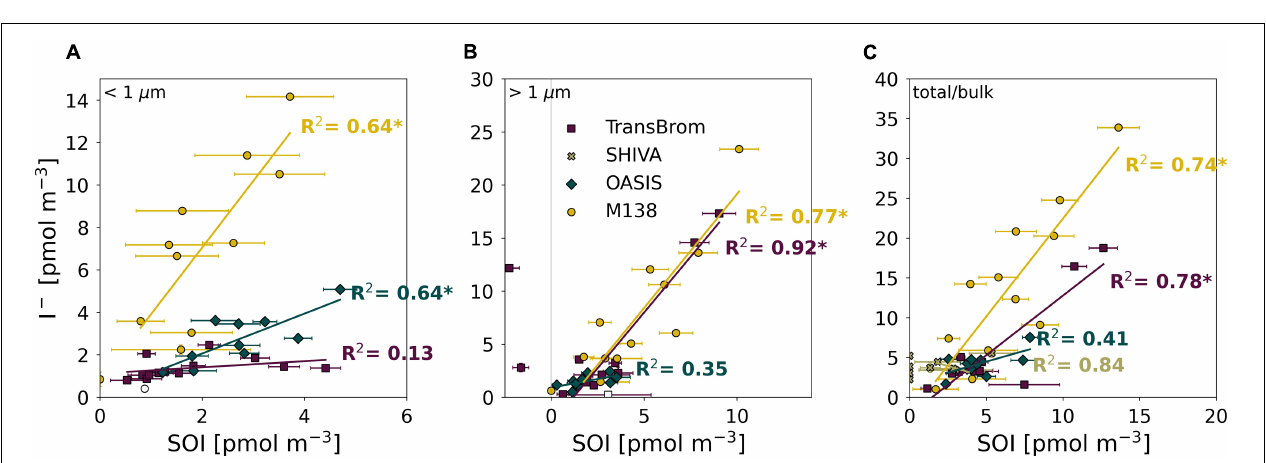
FIGURE 8 | SOI and I - concentrations plotted against each other for the fine (A) , coarse (B) , and bulk/total mode (C) aerosol samples of TransBrom (purple), SHIVA (light green), OASIS (blue-green), and M138 (yellow). Empty markers indicate samples where the I - concentration was below detection limit. The two coarse mode samples with negative SOI concentrations for TransBrom have been excluded from linear regressions. R-squared value of each regression line are shown in the plot. * indicates a significant linear relationship p < 0.01.